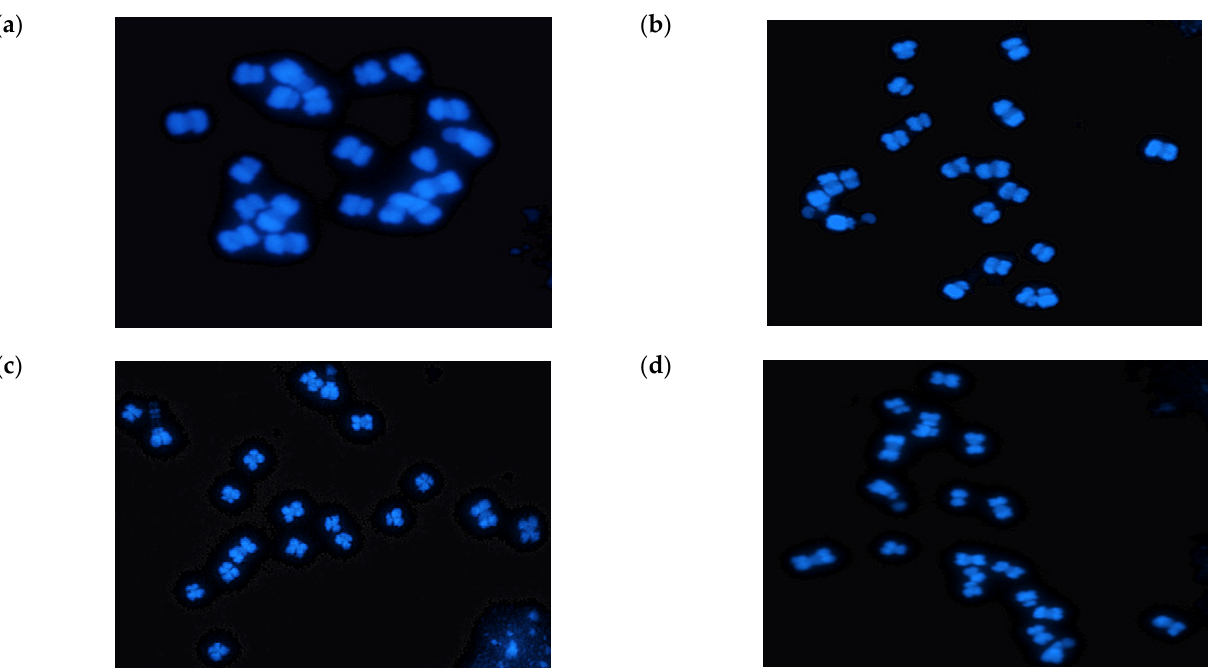
Figure 2. Analysis of chromosome number of non-transgenic and transgenic Chinese cabbage plants. ( a ) Non-transgenic control ‘CT001’ line ( b ) IGA7 ( c ) IGA74 ( d ) IGA743. The number of chromosomes in both non-transgenic control and transgenic plants was found to be 20.